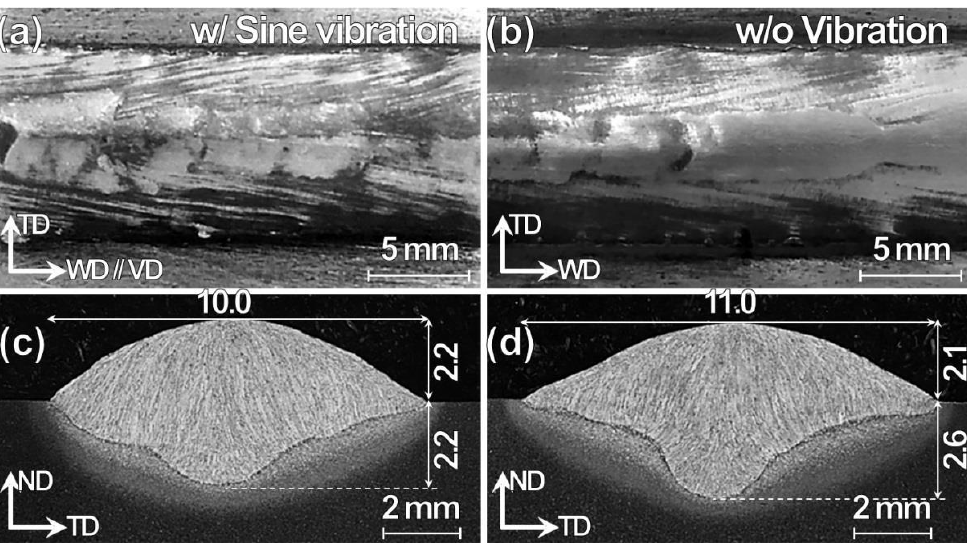
Figure 2. ( a , b ) Top-view and ( c , d ) cross-sectional optical microscopy (OM) images for Tandem-pulsed Figure 2. ( a ), ( b ) Top-view and ( c ), ( d ) cross-sectional optical microscopy (OM) images for Tandem- gas metal arc welding (TP-GMAW) specimens at 1.2 m / min ( a , c ) w / and ( b , d ) w / o sine vibration pulsed gas metal arc welding (TP-GMAW) specimens at 1.2 m/min ( a ), ( c ) w/ and ( b ), ( d ) w/o sine (vibration frequency (F) = 250 Hz, vibration acceleration peak (G) = 1.2 m / s 2 and time of vibration after vibration (vibration frequency (F) = 250 Hz, vibration acceleration peak (G) = 1.2 m/s 2 and time of welding ends (T) = 30 vibration after welding ends (T) = 30 s).